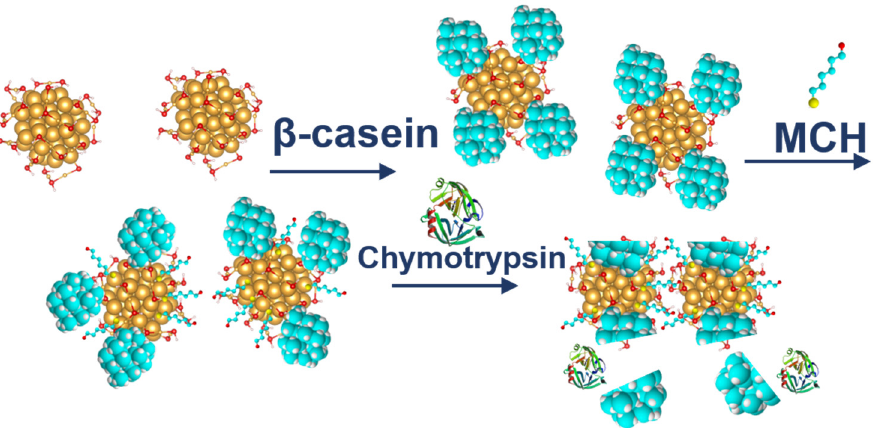
Figure 1. The scheme of gold nanoparticles (AuNPs) modification by 6-mercapto-1-hexanol (MCH) and β -casein and cleavage of β -casein by chymotrypsin.